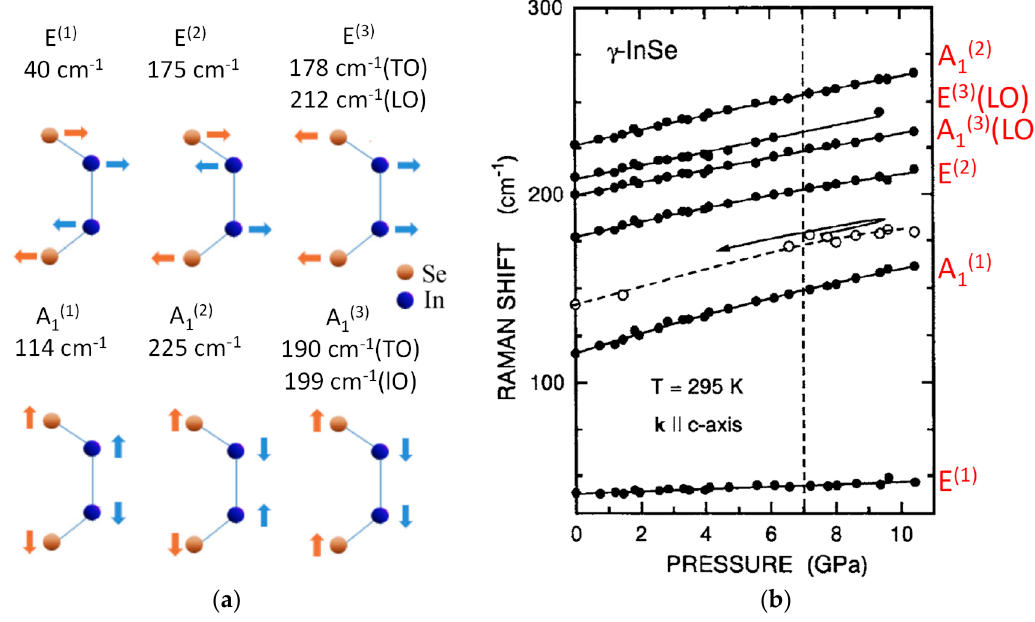
Figure 16. Phonons in γ -InSe. ( a ) Vibration schemes of the normal modes at the Γ point. ( b ) Pressure dependence of the normal modes frequencies [75].